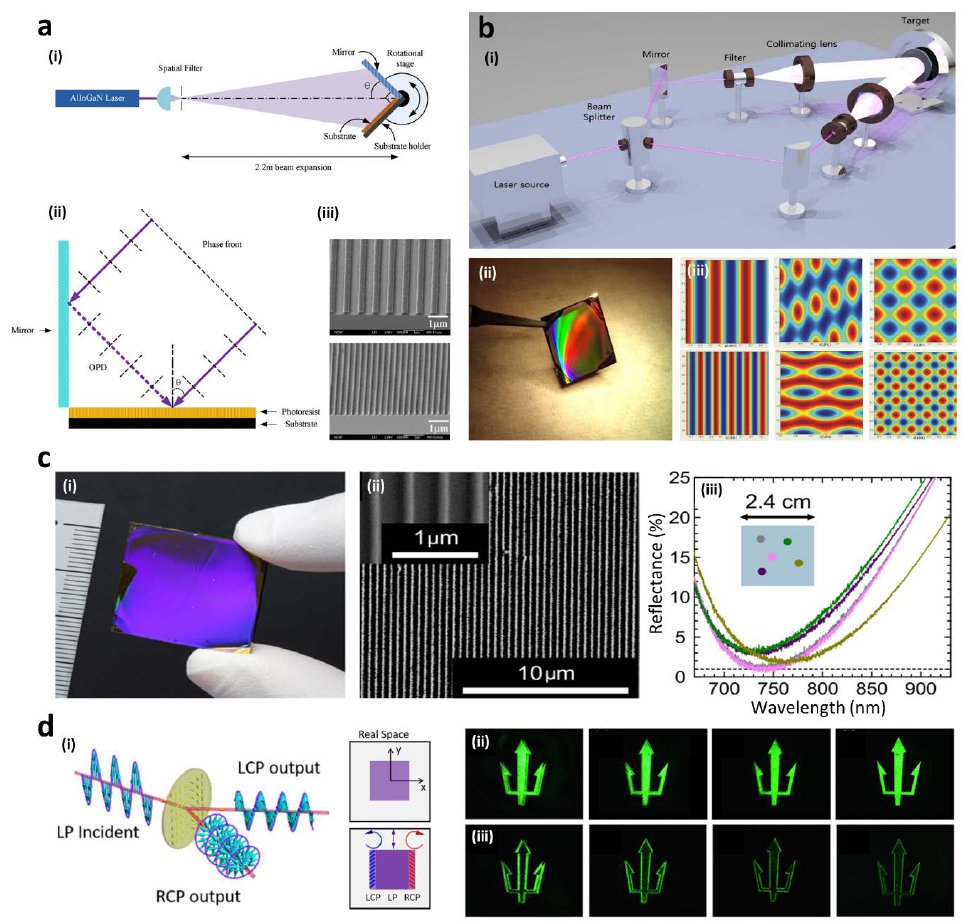
Figure 3. ( a ) (i) Schematic of a laser interference lithography (LIL) system using Lloyd’s mirror module, (ii) magnified schematic of (i) at the mirror and sample holder stage, (iii) SEM image of fabricated 1D gratings using the Lloyd’s mirror LIL: (top) 190 sec / 750 nm and (bottom) 300 sec / 290 nm of the exposure time / period, respectively [85]. ( b ) (i) Illustration of a LIL system using the beam splitter, (ii) photograph of a fabricated sample based on the LIL using beam splitter, (iii) di ff erent simulation results of interference using (left) two beams, (middle) three beams, and (right) four beams [90]. ( c ) (i) Photograph and (ii) SEM image of a spectrally selective perfect absorber using the LIL, (iii) measured reflectance spectra at 5 random positions [99]. ( d ) (i) Schematic of the edge detection concept based on a pre-designed phase gradient metasurface, (ii) measured images of two left- and right-circularly polarized (LCP and RCP) lights without the analyzer, playing a role as a reference, (iii) edge images corresponding to (ii). The resolution of pattern is 500, 750, 1000, and 8000 µ m in both (ii) and (iii) from left to right, respectively [100]. Reproduced with permission from ( a ) [85]; IOP Publishing Ltd.,